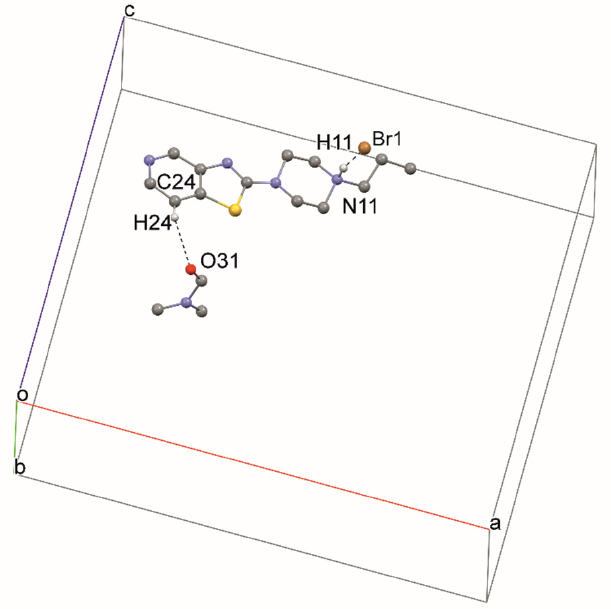
Figure 7. The crystal packing of 1 , viewed along the a-axis, where a, b and c denote unit cell axes.